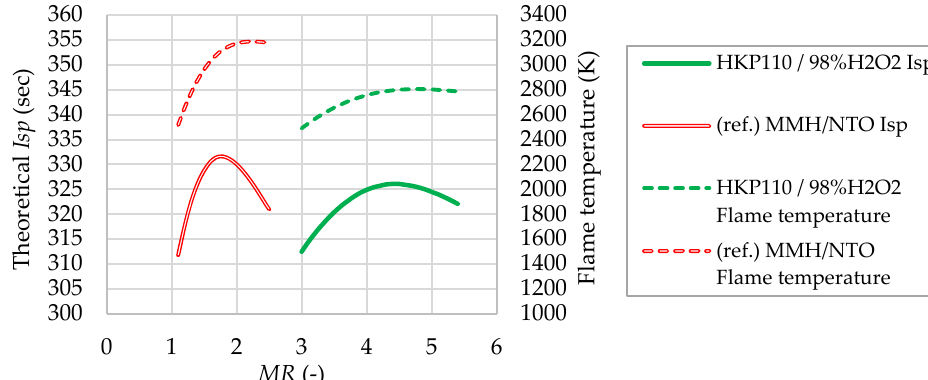
Figure 1. Theoretical Isp and adiabatic flame temperature of HKP110 fuel (calculated by CEA [18], conditions: nozzle expansion ratio = 100, frozen flow at throat, initial chamber pressure = 10 atm, propellant temperature = 300 K, calculated results of MMH/NTO are also plotted as references).